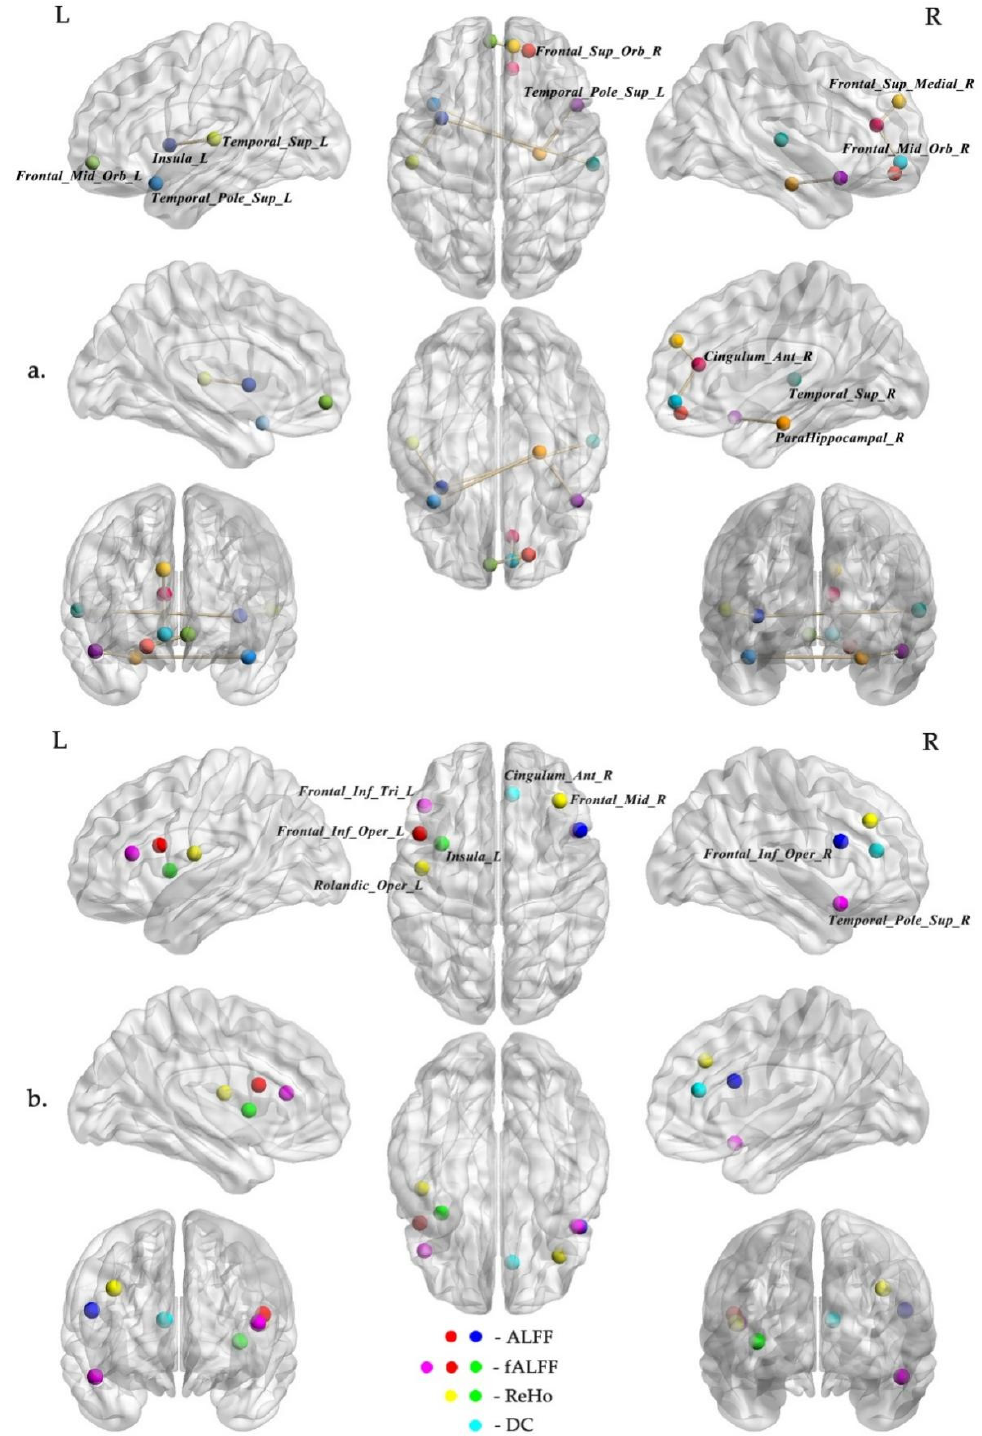
Figure 3. The selected rs-fMRI features set for discriminating the SCC from HC group. Part ( a ) showed the FC features, and part ( b ) showed the ALFF, fALFF, ReHo and DC features. Abbreviations: ALFF, amplitude of low frequency fluctuation; fALFF, fractional ALFF; ReHo, regional homogeneity; DC, degree centrality; L, left; R, right.